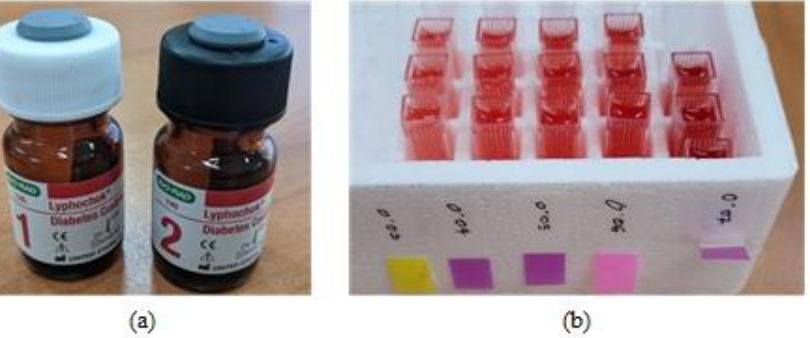
Figure 3. Sample preparation: ( a ) Bio-Rad Lyphocheck diabetes management bilevel solution; ( b ) sample solutions of different concentrations for levels 1 and 2.